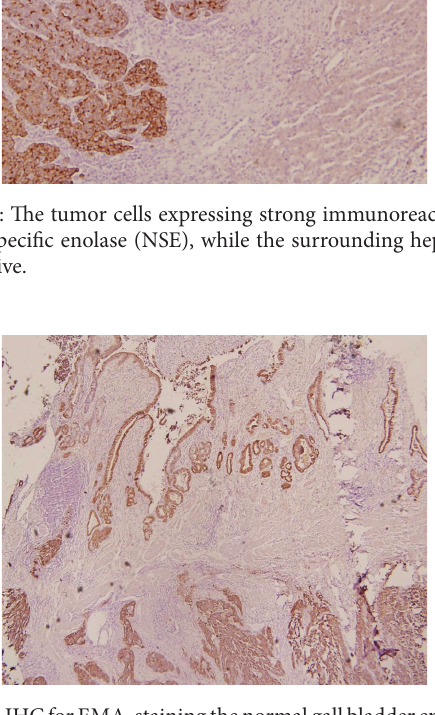
Figure3:IHCforEMA,stainingthenormalgallbladderepithelium and the nests of tumor cells infiltrating the wall of the gall